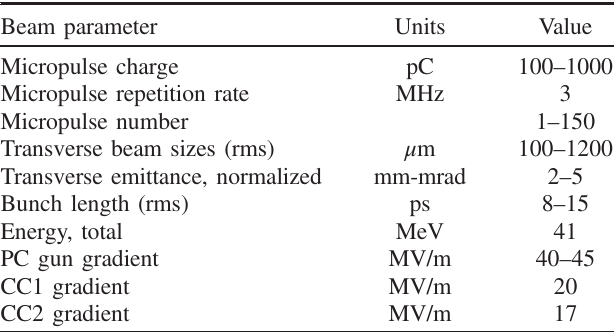
TABLE I. Summary of the FAST electron-beam parameters used in the SRW